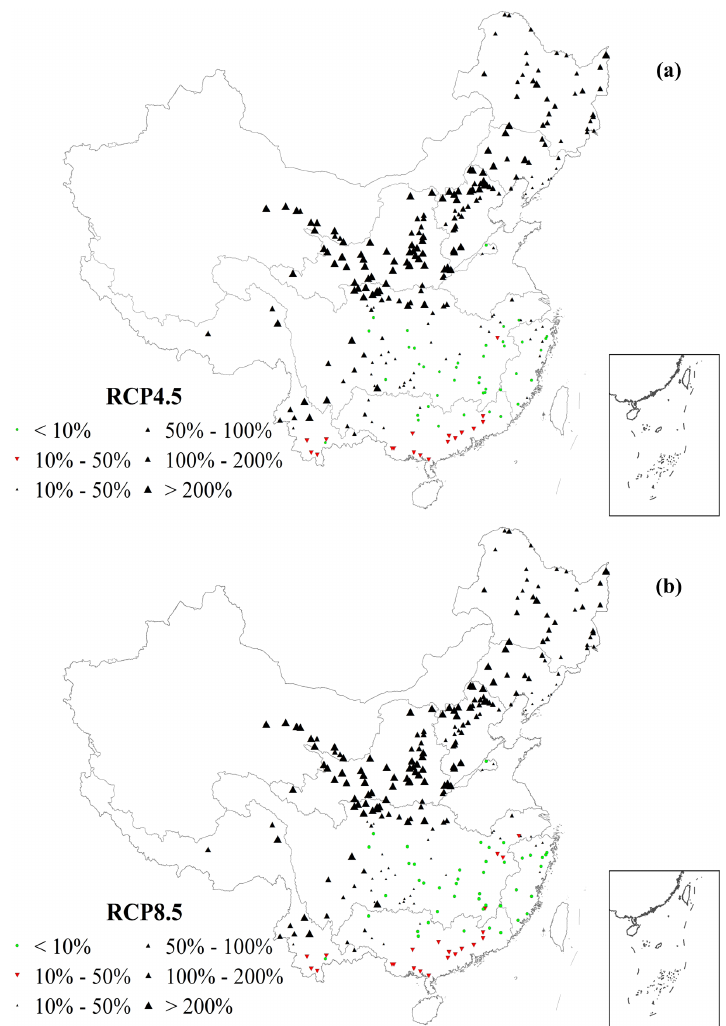
Figure 8. Change rate of mean annual runoff under projected future climate. (a) RCP4.5 and (b)